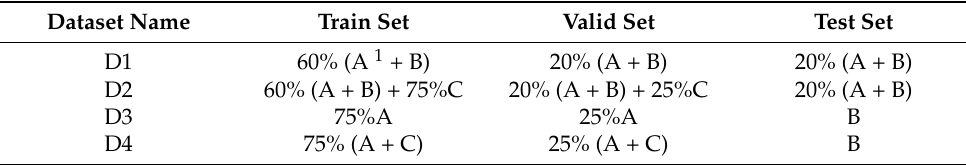
Table 3. Components of the datasets.